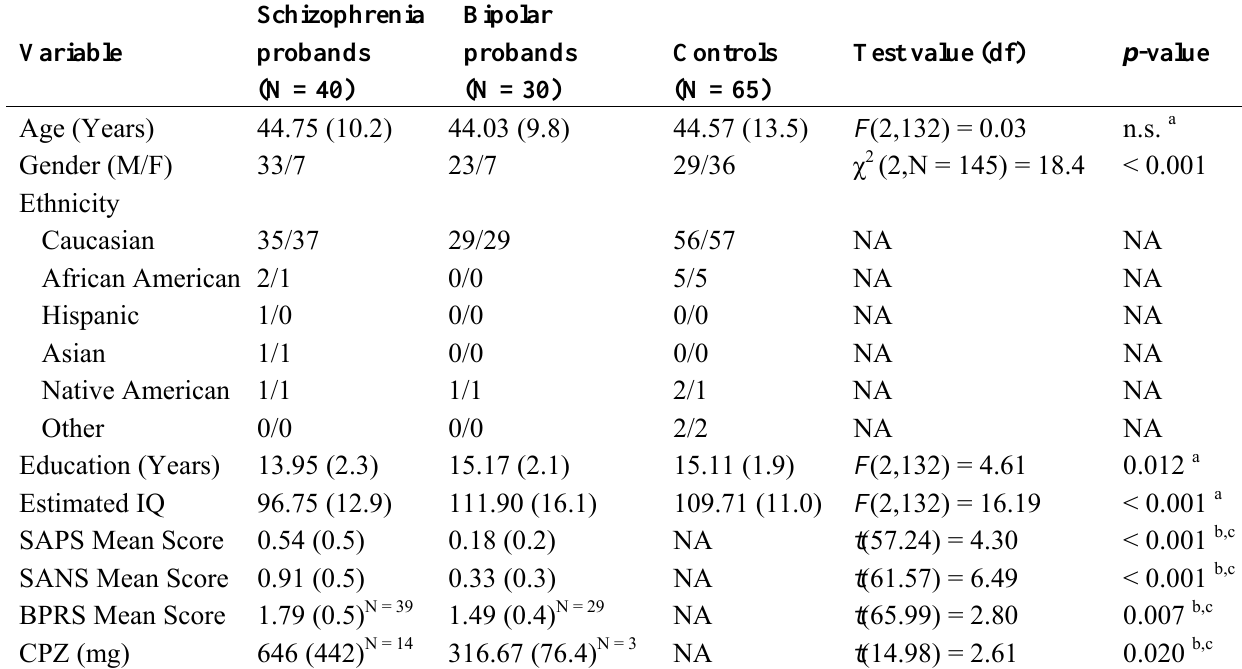
Table 1. Participant characteristics: demographic and clinical information for schizophrenia probands, bipolar probands and nonpsychiatric